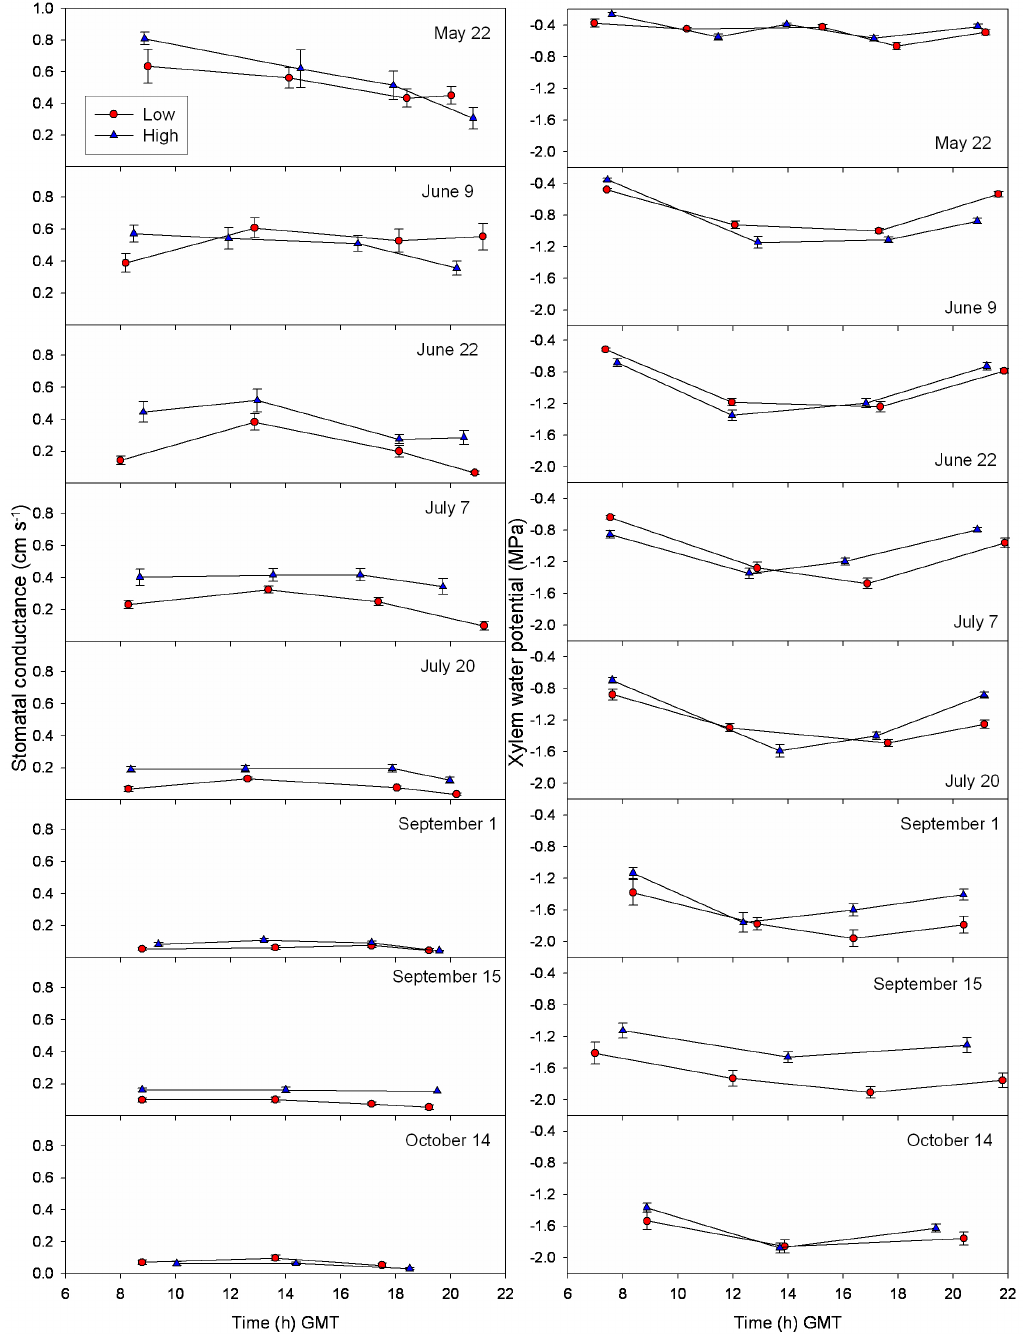
Figure 3. Diurnal gas exchange (left column) and xylem water potential (right column) of Abies pinsapo trees located at low (1200m, circles) and high elevation (1550 m, triangles). Error bars indicate the standard error ( n = 5 trees (3 twigs per tree) per